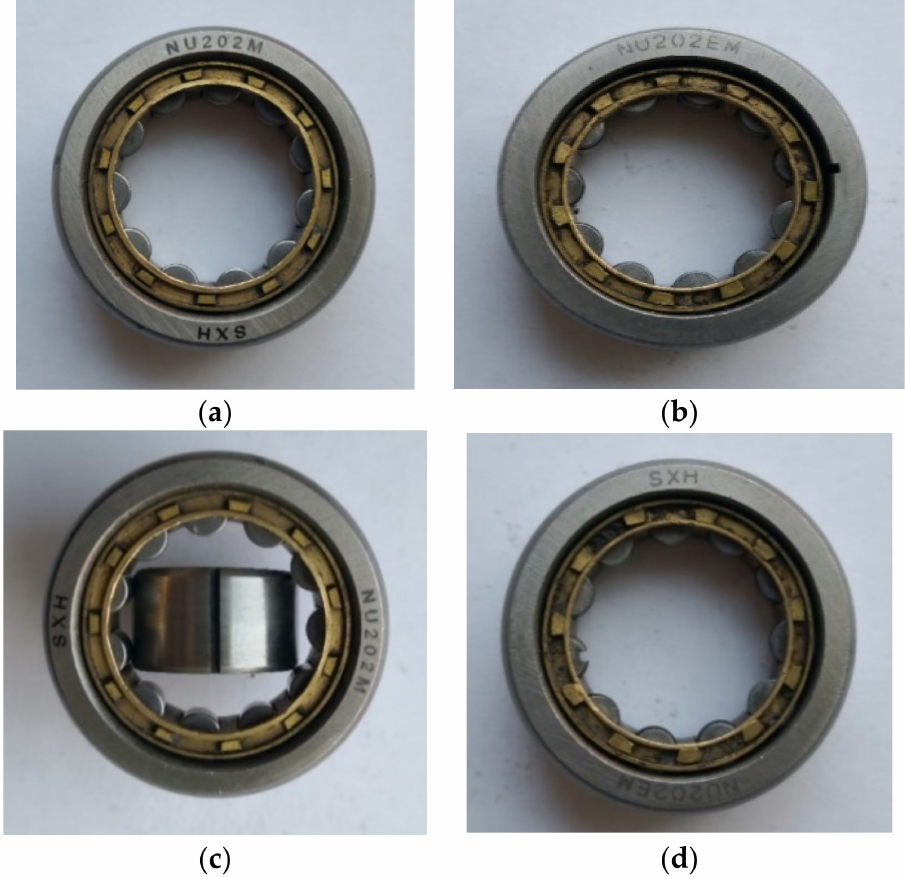
Figure 10. Inter-shaft bearing with local defects. ( a ) Normal statet; ( b ) outer-ring fault; ( c ) inner-ring fault; ( d ) roller